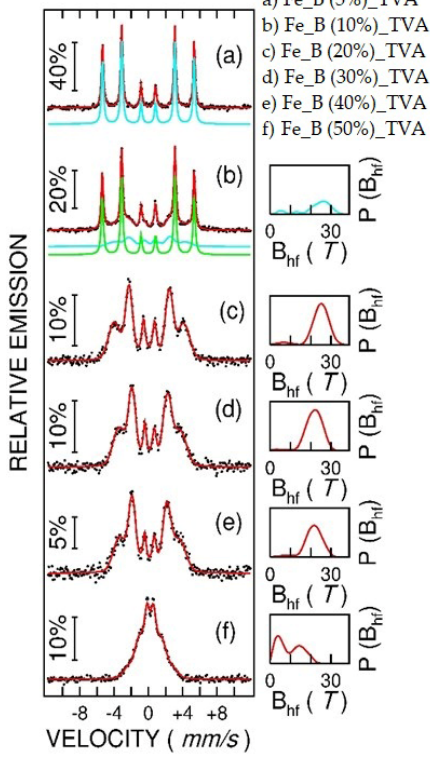
Figure 6. RT CEM spectra of Fe-B thin films obtained by TVA, with the following nominal composi- tions of B (in at. %): 5% ( a ), 10% ( b ), 20% ( c ), 30% ( d ), 40% ( e ), 50% ( f ). The vertical bars indexes the effect of the spectra (in %). The probability distributions of the hyperfine magnetic field are shown on the right hand of the spectra. The black dots are experimental points, the blue and green continuous lines provides the spectral components discussed in the text whereas the red lines represent the total spectral envelope given by the fit.